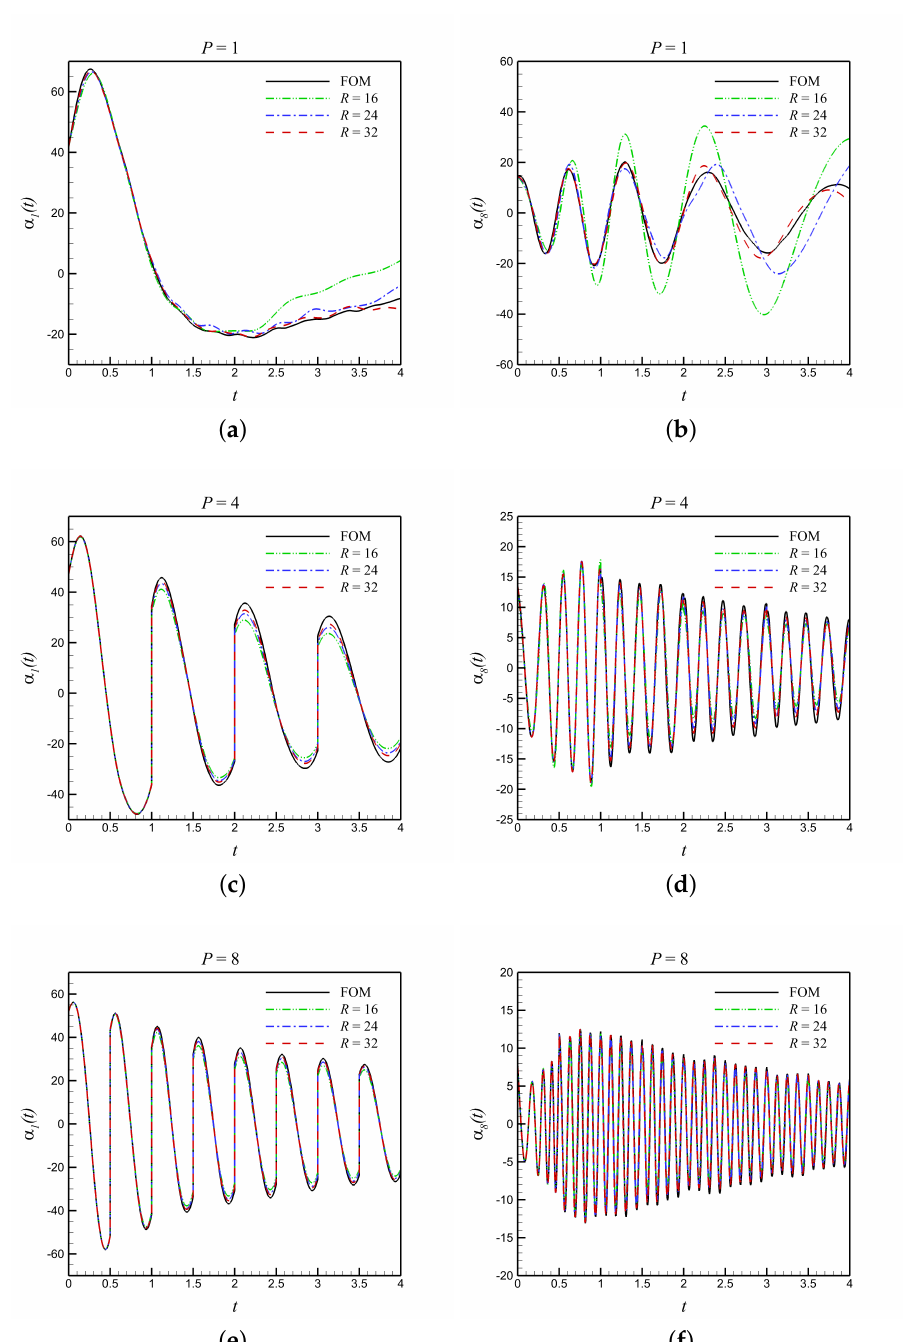
Figure 4. Temporal evolution of the first and eighth modal coefficients using different numbers of partitions, compared to the true values obtained from the projection of FOM vorticity field on the corresponding basis function. ( a ) shows the first modal coefficient with P = 1, while the eighth is given in ( b ). Results for P = 4 are shown in ( c,d ), while those for P = 8 are given in ( e,f